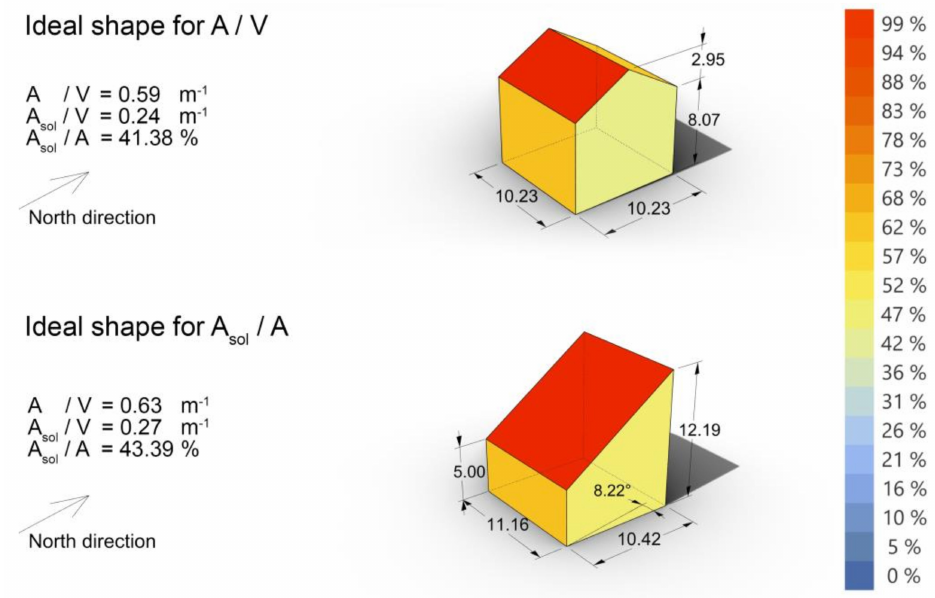
Figure 10. Top : ideal shape for surface-area-to-volume ratio; bottom : shape optimised simultane- ously for both indicators, A/V and A sol